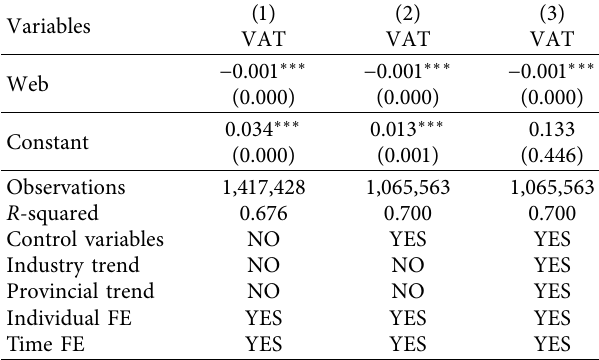
Table 12: Evidence of acquisition planning